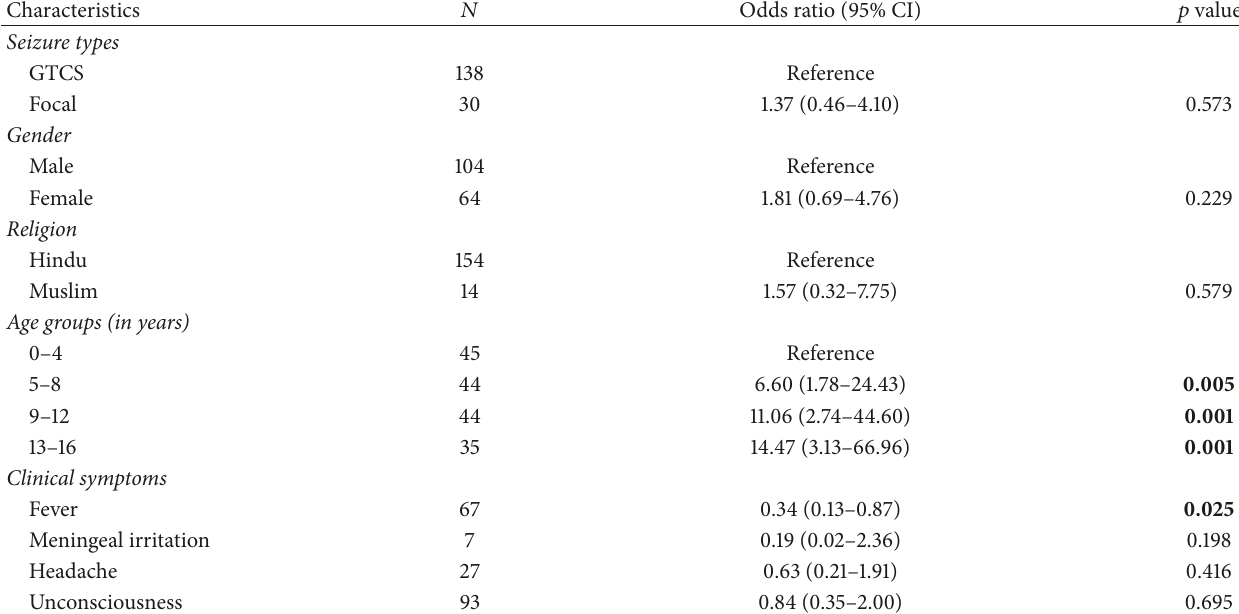
Table 3: Relationship between NCC with types of seizures, various sociodemographic characteristics, and clinical